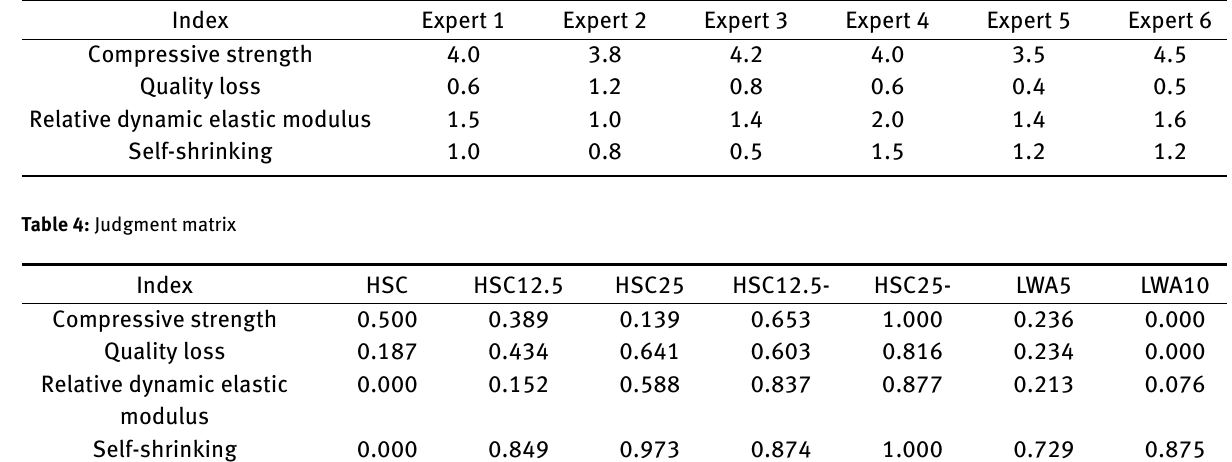
Table 3: Expert score of comprehensive performance indexes of internally cured concrete Index